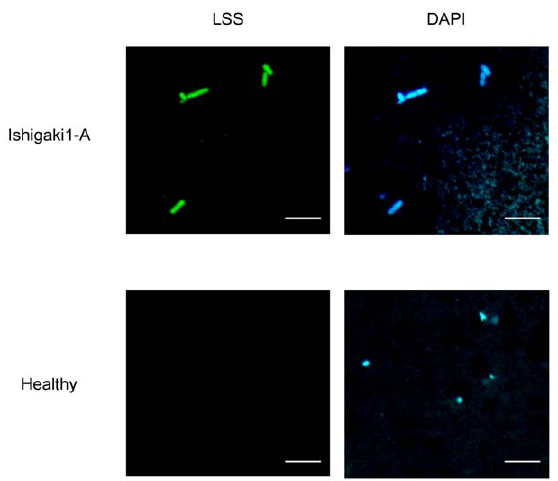
Figure 3. Fluorescence insitu hybridization (FISH) assay with Las-specific probe. The Biomasher-pellet from Ishigaki1 Las-infected leaves or healthy leaves was filtered with 5- m m and used for FISH assay to detect Las bacterium bodies. Upper panels indicate Ishigaki1-A Las- infected leaves, and lower panels indicate healthy leaves. Left panels, FISH with Las-specific probe, LSS. Right panels, 4 9 ,6-diamidino-2- phenylindole (DAPI) staining. Scale bar indicates 5 m m.